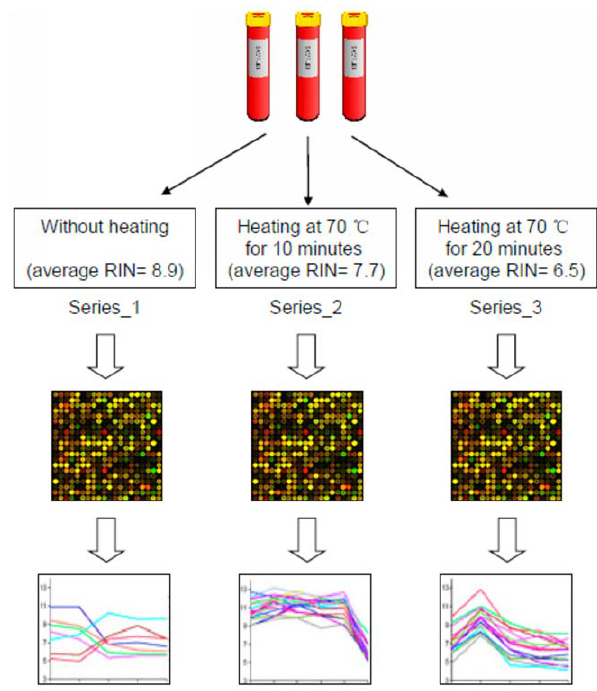
Figure 3. Illustrations of principle component analysis on the blood sample gene expression profiles. Principle component analysis was performed on gene expression profiles of 24 blood samples. Samples were displayed in three-dimensional space consisting of the Top-3 principal components which explain 55.4% of the variation of the whole dataset. Colours indicate blood samples collected from the same volunteers. Circles represent females and crosses represent male. The distances between samples reflect their approximate degree of transcriptional similarity. The individuals across three experimental series were in close proximity to one another, whereas females and males were separated. doi:10.1371/journal.pone.0026905.g003 Table 2. Eigen-R 2 analysis for dissecting data variation,variable-associated gene identification and functional annotation enrichment.